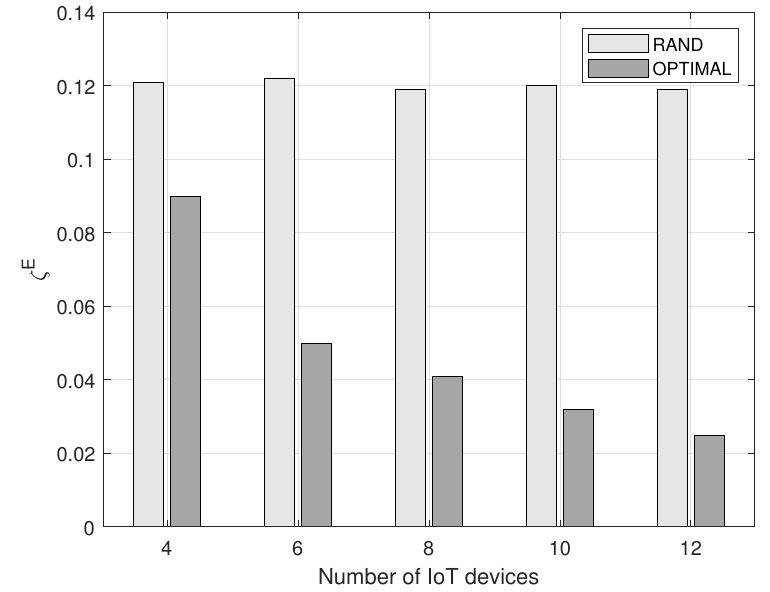
Figure 7. Comparison between the optimal pairing and random